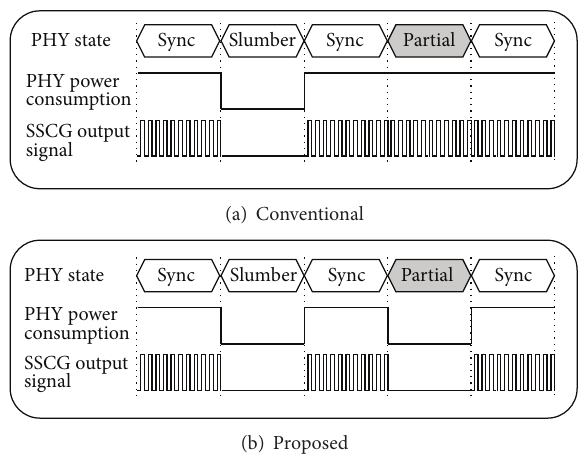
Figure 2: Proposed low power SATA-PHY operation.